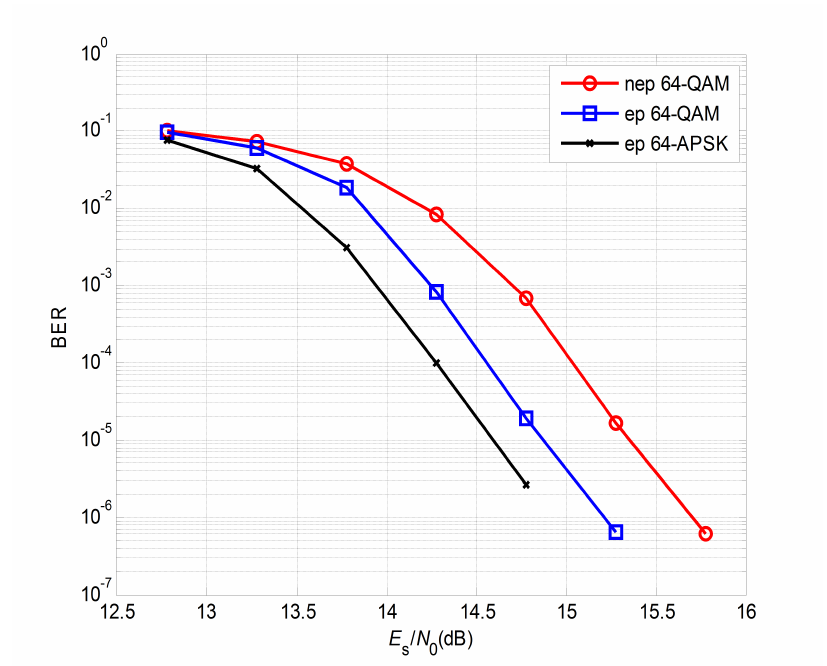
Figure 8. BER performance of different constellations over the linear